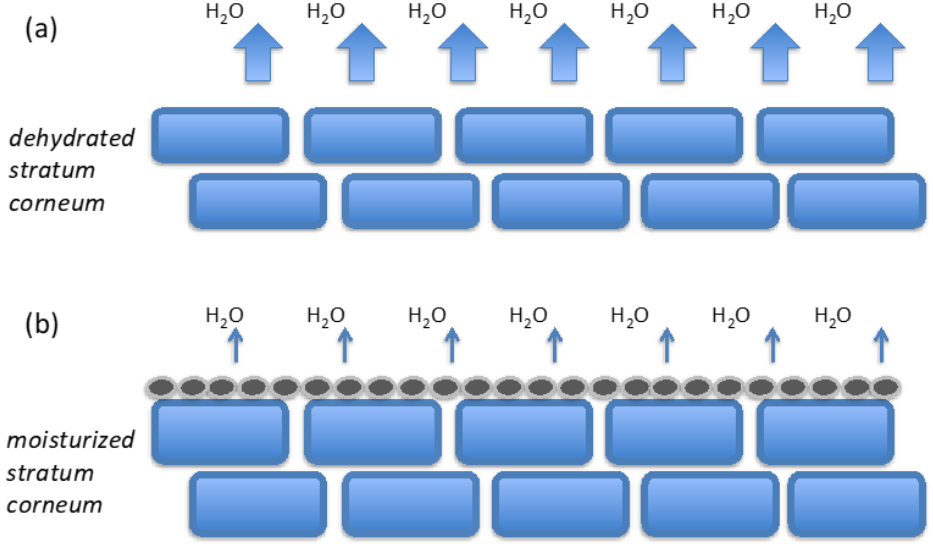
Figure 6. Effect of SLNs or NLCs on TEWL and on skin hydration. ( a ) Water evaporation of untreated skin. ( b ) Occlusion effect of LBNs reducing